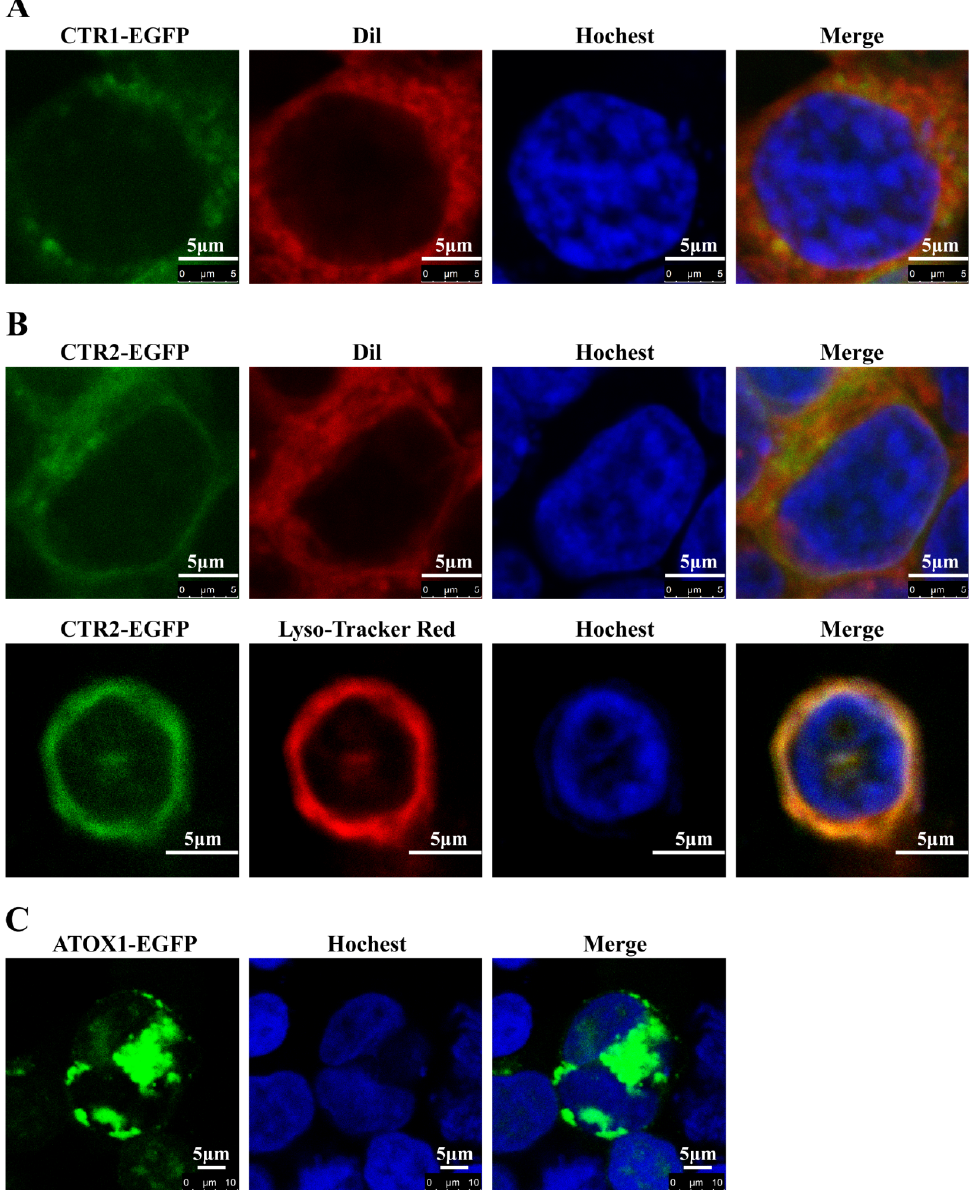
Figure 6. Subcellular localization of yellow catfish CTR1, CTR2 and ATOX1. ( A ) Subcellular localization of CTR1; ( B ) Subcellular localization of CTR2; ( C ) Subcellular localization of ATOX1. CTR1-EGFP, CTR2-EGFP and ATOX1-EGFP were transfected into the HEK293T cells. Cell membrane, nucleus and lysosome were stained with Dil, Hochest and Lyso-Tracker Red, respectively. A laser scanning confocal microscope was used to visualize the localization.